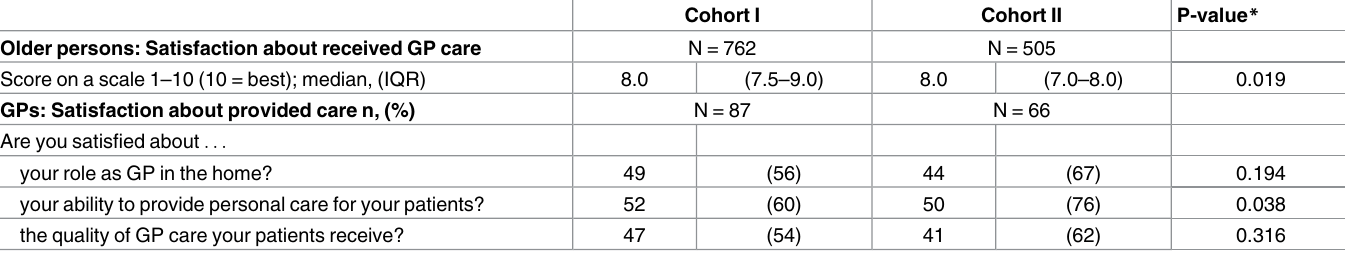
Table 2. General satisfaction about General Practitioner care reported by older persons and General Practitioners. Cohort I Cohort II P-value